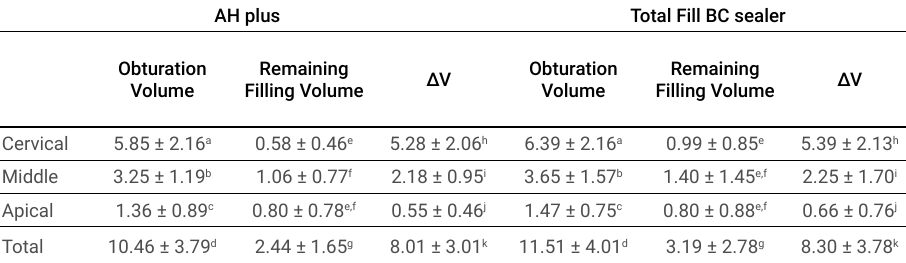
Table 1. Mean ± standard deviation (mm 3 ) of obturation volume, remaining filling volume and ΔV in the cervical, middle, apical and entire root canal AH